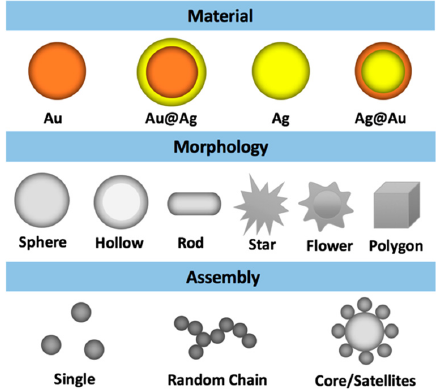
Figure 3. Types of Au and Ag nanoparticles with different morphologies and assembly states. Reprinted with permission from ref. [43]. Copyright 2019 American Chemical Society. Among many designs of pH Raman probes, the traditional pH SERS probes combine pH sensitive molecules with single particles through chemical or physical action, which is a relatively simple design. It has the advantages of small volume and low difficulty in preparation. In an earlier study, Kneipp et al. [51] demonstrated mobile SERS nanosensors made of gold nanospheres’ aggregates and 4-mercaptobenzoic acid (pMBA) for monitor- ing local pH changes in living NIH/3T3 cells. As more and more research groups used precious metal nanoparticles functionalized by acid ligands to carry out surface enhanced Raman scattering to realize the highly sensitive monitoring of intracellular pH value, re- searchers gradually turned their attention to the dependence of pH SERS sensitivity on the morphology of nanoparticles (Figure 4a). Schwartzberg et al. [52] realized the SERS measuring scale for hollow nanostructures for the first time and demonstrated it as a pH sensor model system. Compared with the previous pH SERS probes, its resolution was nearly doubled, and its accuracy was improved by 10 times (Figure 4b). This new detec- tion platform is an important step forward in potential biosensor applications. It is well known that the apparent dissociation constant (pKa) of acid ligands (pH Raman reporter molecules) is sensitive to nanoparticle curvature, and that flower-shaped or star-shaped nanoparticles have higher curvature than near-spherical nanoparticles. In addition, the phenomenon that flower-like and stellate-like nanoparticles have single-particle Raman signals has been widely reported. In this connection, Zhang [53] successfully obtained the visualized intracellular pH value (pHi) and the pHi curve of living cells through the func-